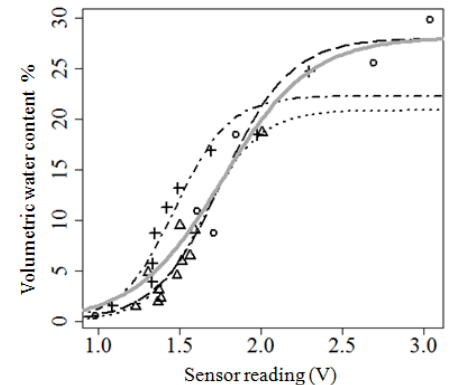
Figure 4. Calibration of soil water content dielectric probes on three soil media. Symbols = data points: Open triangles = sand; open circles = loamy-clay soil; crosses = sandy soil. Lines = model results: Dotted line = sand; dashed line = loamy clay soil; dotted-dashed line = sandy soil; solid grey line = overall